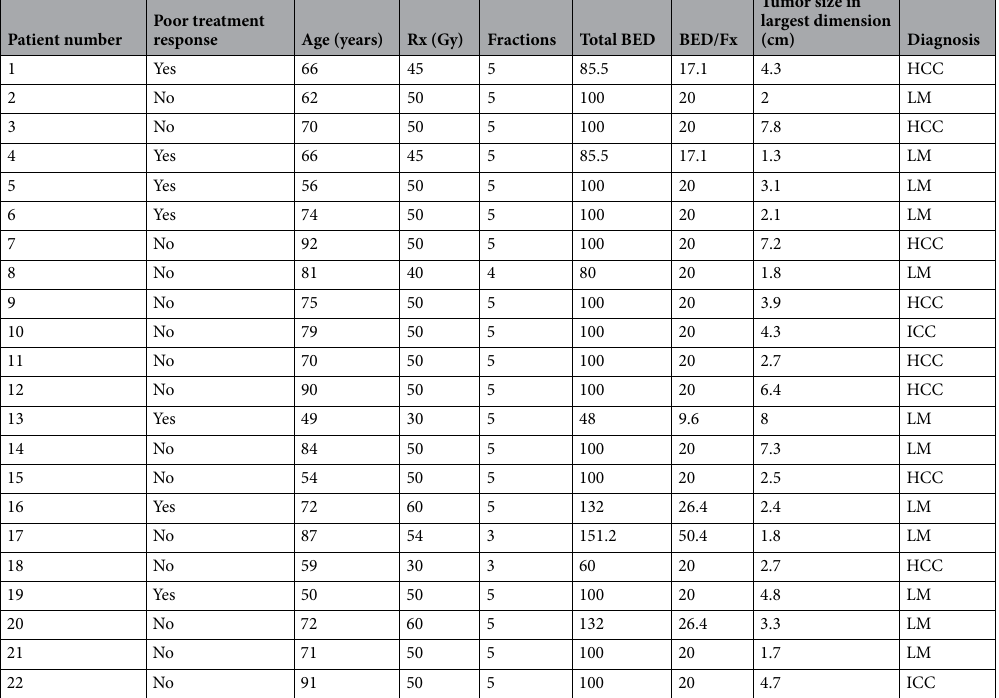
Table 1. Patient variables included for delta-radiomics texture analysis. BED, biologically effective dose (calculated using α/β = 10); HCC, hepatocellular carcinoma; ICC, intrahepatic cholangiocarcinoma; LM, secondary liver